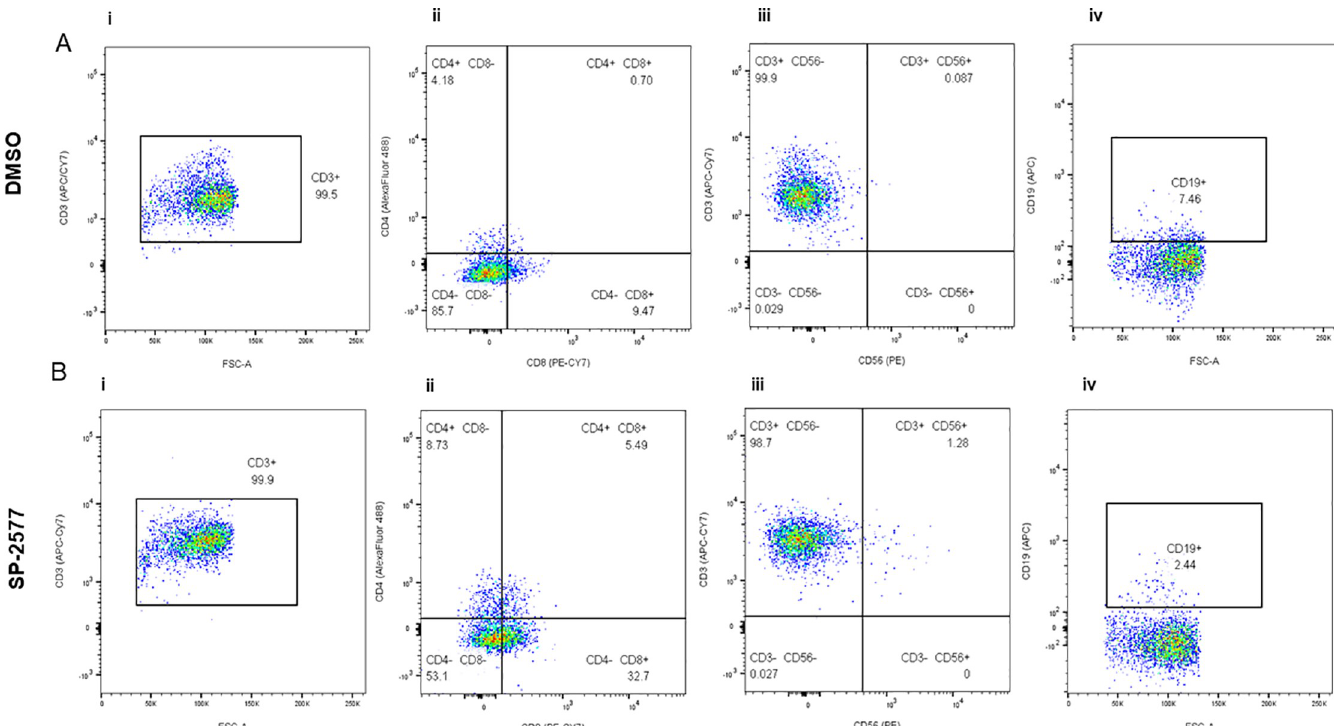
Fig 4. Flow cytometry analysis of the COV434 organoids after lymphocyte infiltration assay. COV434 organoids were dissociated and the infiltrated lymphocytes were stained with different markers and analyzed by flow cytometry as described in ‘Materials and Methods’. Panel A and B are showing the status of lymphocytes infiltrated in DMSO control organoids and SP-2577 treated organoids, respectively, in the representative dot plots. (Ai and Bi) The dot plots showed the CD3 + population in CD45 + gated lymphocytes. (Aii and Bii) The status of CD4 + and CD8+ T cells gated on CD3 + cells are presented in different quadrants. (Aiii and Biii) Percentage of CD56+ NK in CD3+ cells are presented with quadrant statistics. (Aiv and Biv) The status of CD19+ B cells are shown in CD3+ cells.